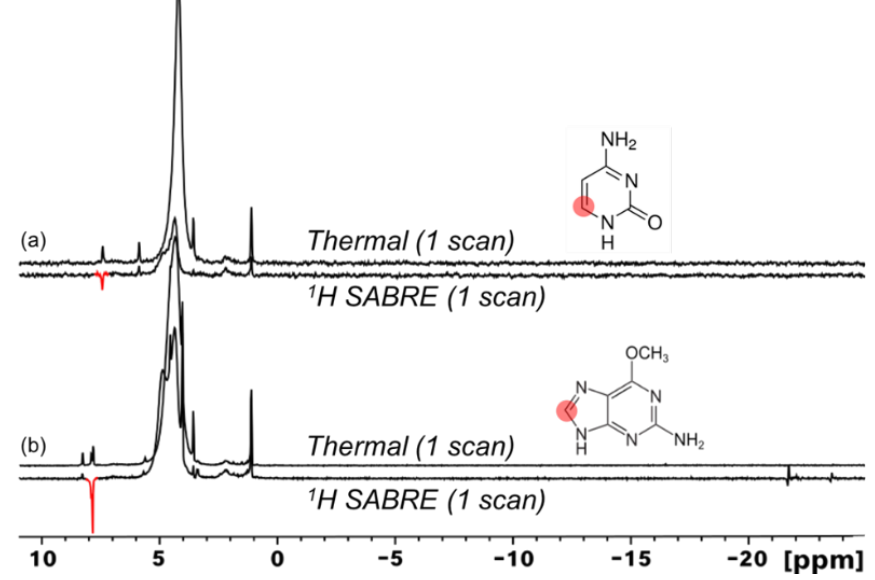
Figure 6. 1 H SABRE spectra of cytosine (( a ), amino tautomer shown) and 6-O-methylguanine ( b ) show minimal hyperpolarization of 1 H nuclei adjacent to binding nitrogen atoms. In ( b ), the bottom spectrum is scaled by a factor of ~1.9 compared to the top spectrum.